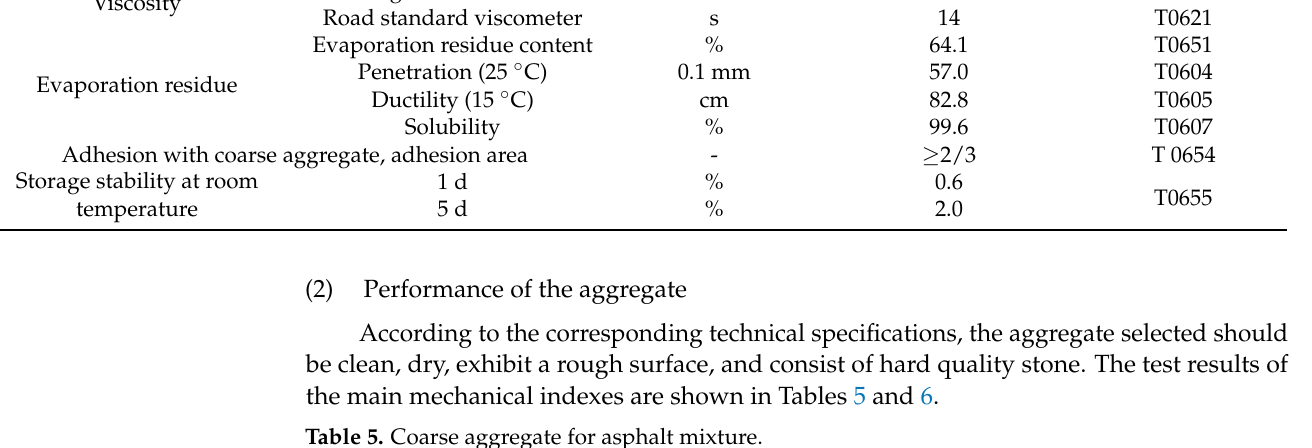
Table 5. Coarse aggregate for asphalt mixture.